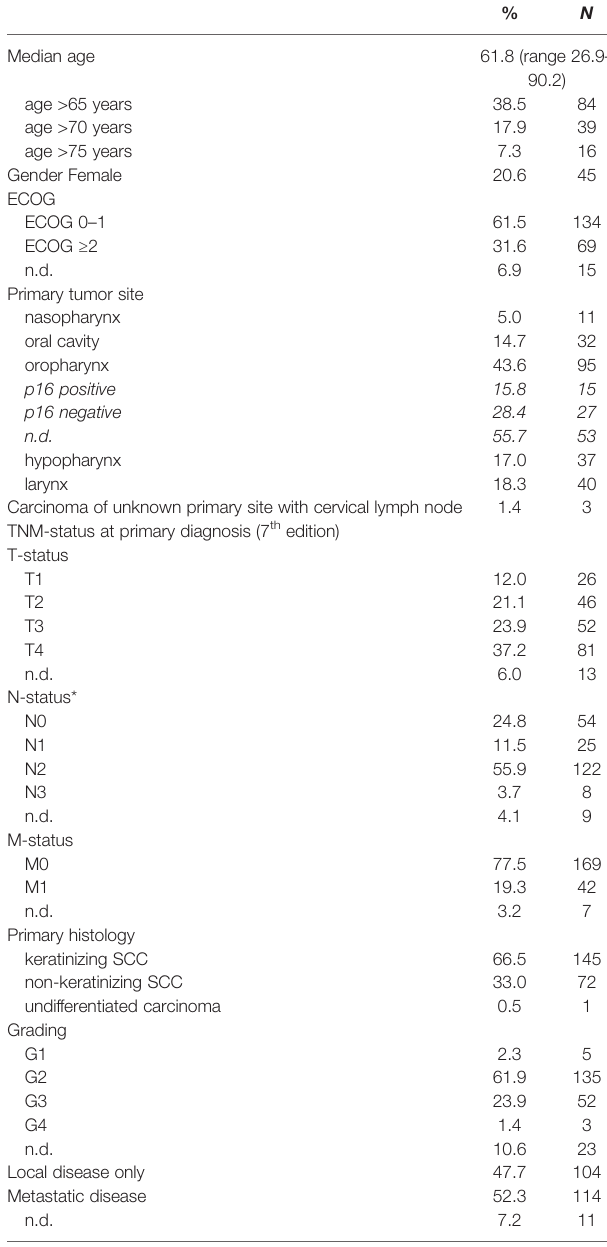
TABLE 1 | Baseline clinical characteristics ( N =